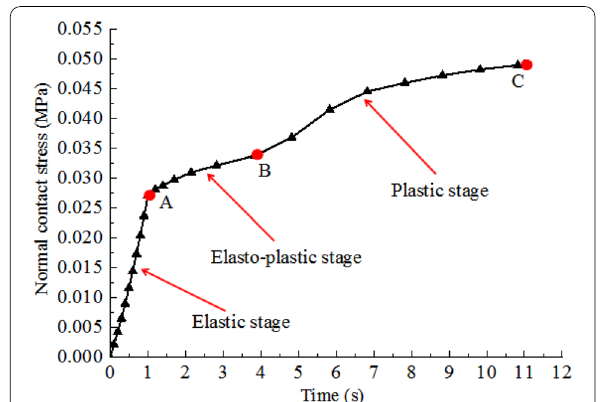
Fig. 17 Normal contact stress–time relation curves of wood normal contact surfaces in FEA